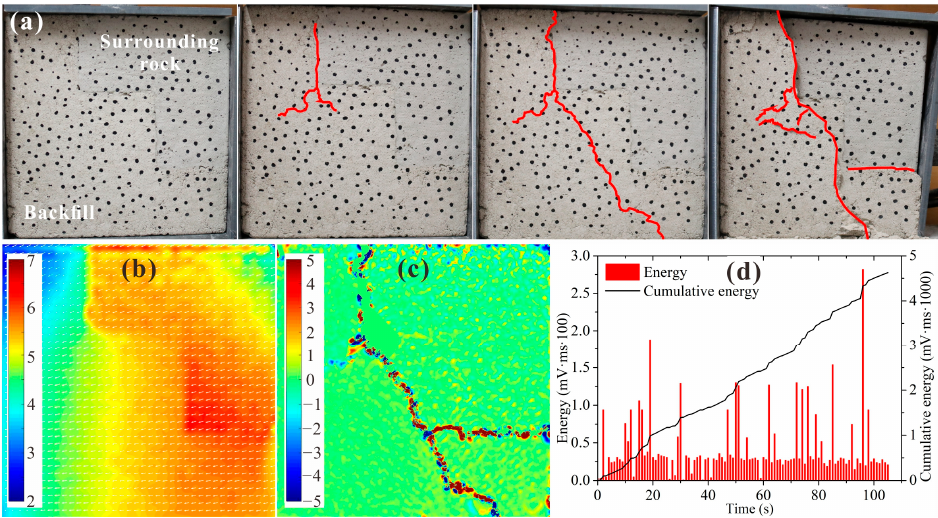
Figure 12. Experimental results for type D. ( a ) Damage and failure processes; ( b ) displacement field; ( c ) strain field; ( d ) acoustic emission energy.